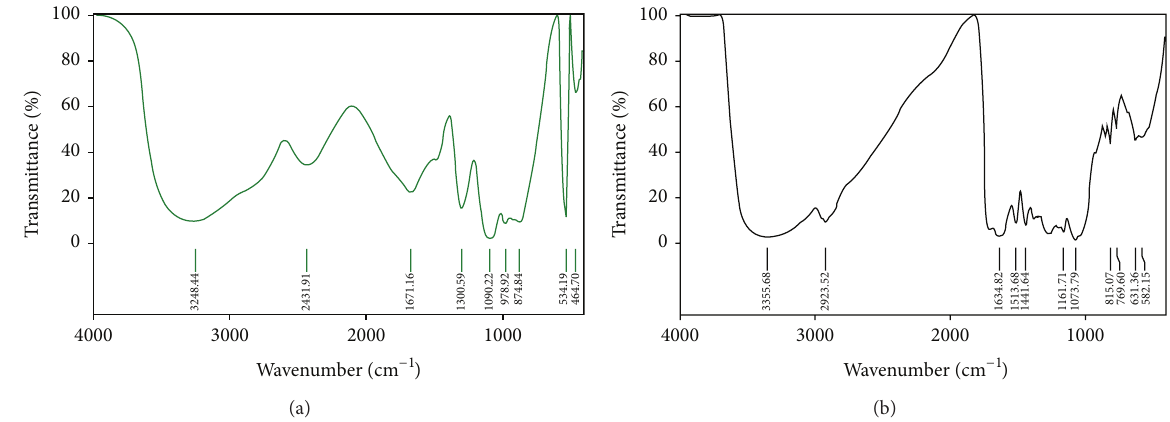
Figure 7: FT-IR spectra of Jaft extract (a) and biosynthesized AgNPs (b). Synthesis conditions: silver nitrate concentration, 1mM; temperature, 45 ∘ C, extract pH, 9; extract concentration,